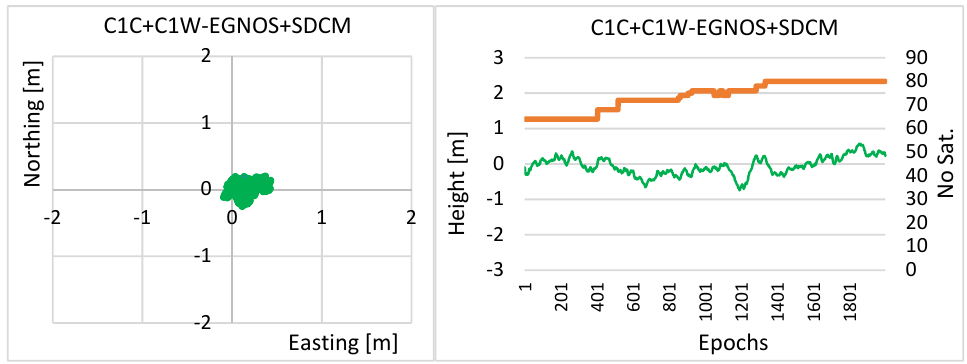
Figure 15. Real errors of finale coordinates of dual receiver GPS/(EGNOS+SDCM) positioning, with the use of C1C and C1W codes.